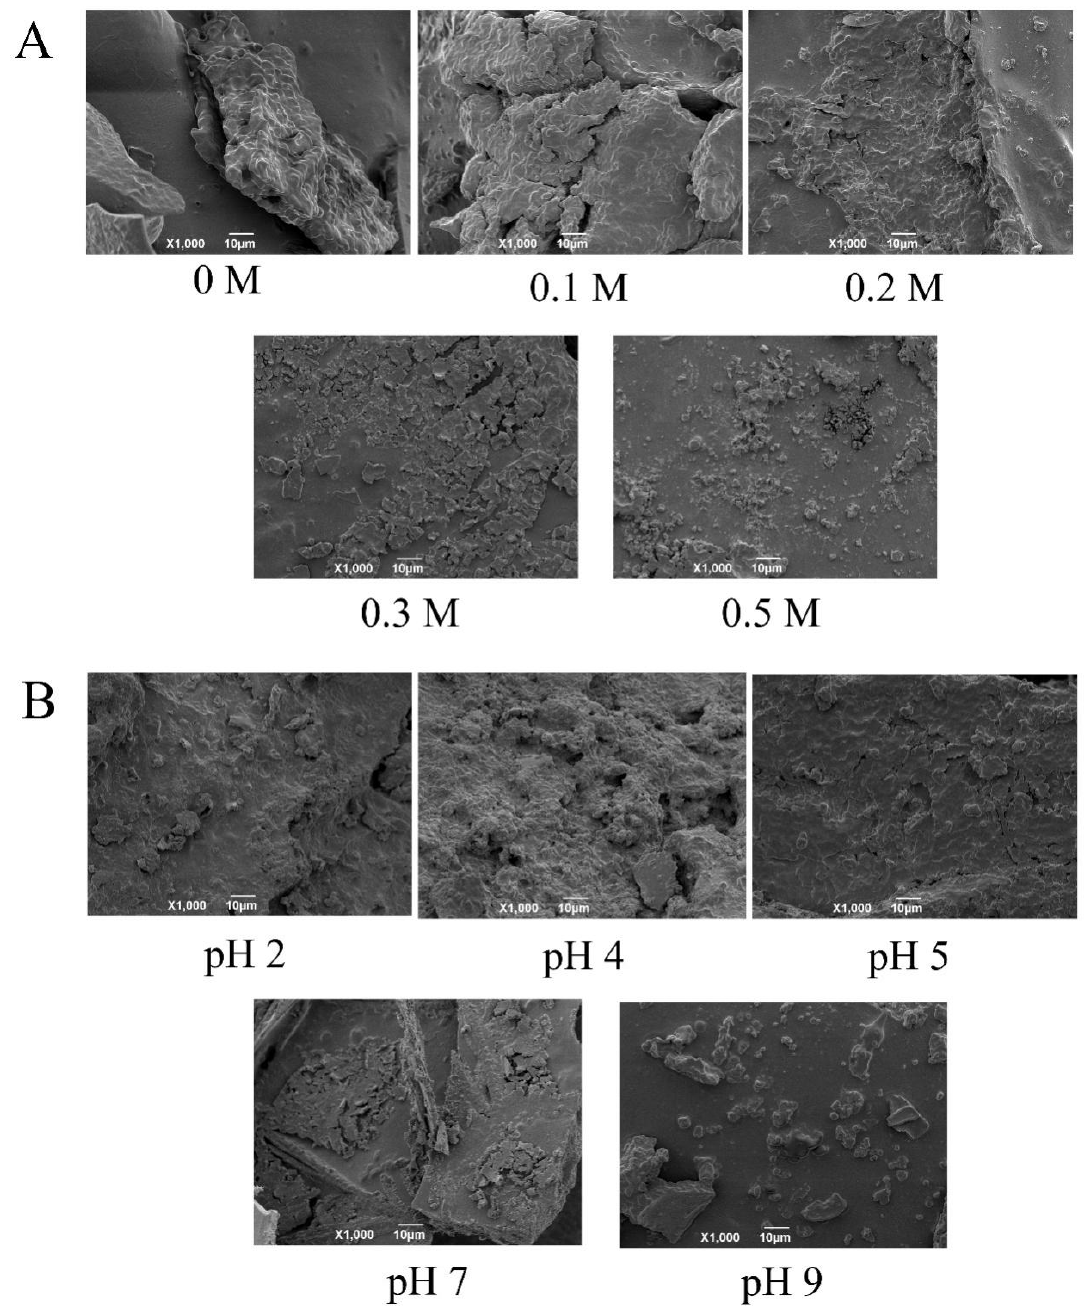
Figure 3. SEM image of EYGs at different NaCl ionic strength ( A ) and at a NaCl ionic strength of 0.3 0.3 M with different pH ( B M with different pH ( B ).